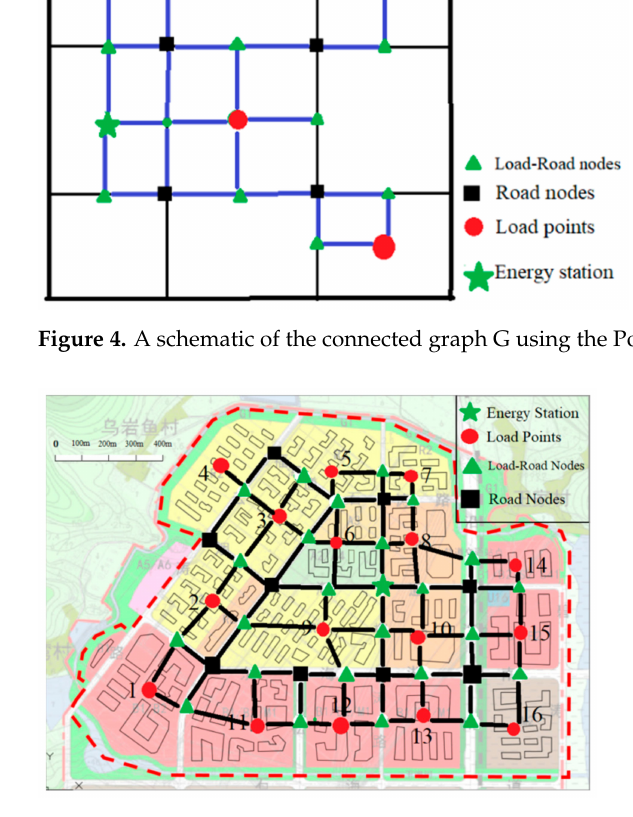
Figure 5. Connected graph G of the study area using the Point-to-Point model.